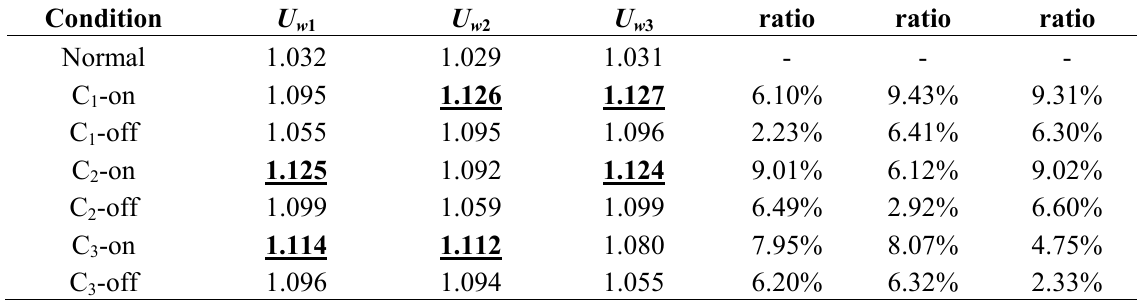
Table 3. Voltage magnitudes at wind farms under normal and N-1 contingency conditions (with/without capacitance